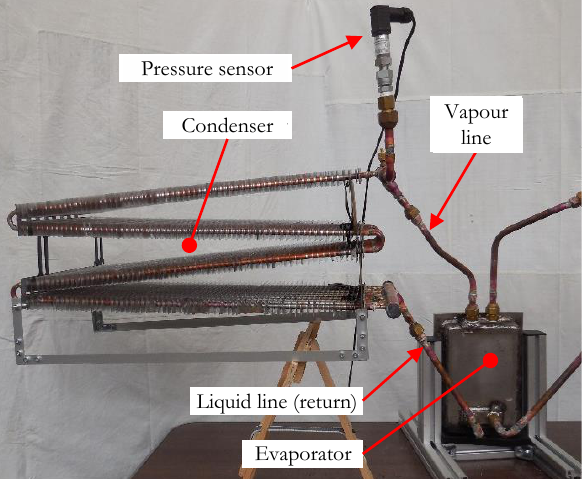
Figure 7. Biphasic thermosyphon employed on one of the thermoelectric generators under free